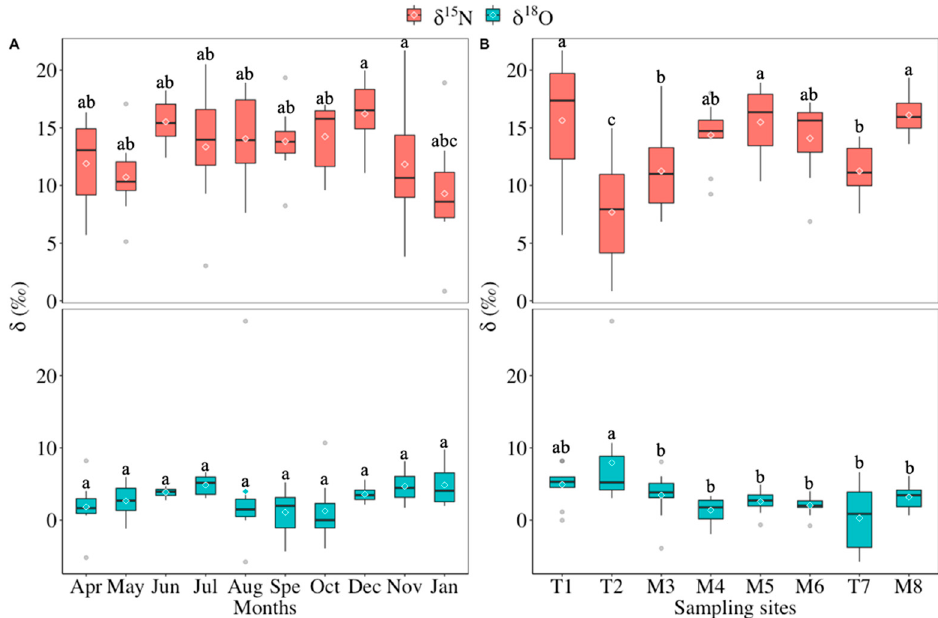
Figure 3. The temporal ( A ) and spatial ( B ) variation in δ 15 N-NO 3 and δ 18 O-NO 3 in eight sites in the Yuntaishan River basin. Letters on boxes represent statistical significance, and different letters and same letters indicate difference between these two boxes is significant ( p < 0.05) and insignificant ( p > 0.05) based on an ANOVA, respectively. Each month in ( A ) is an average of all stations, and each sampling site in ( B ) means the yearly average.